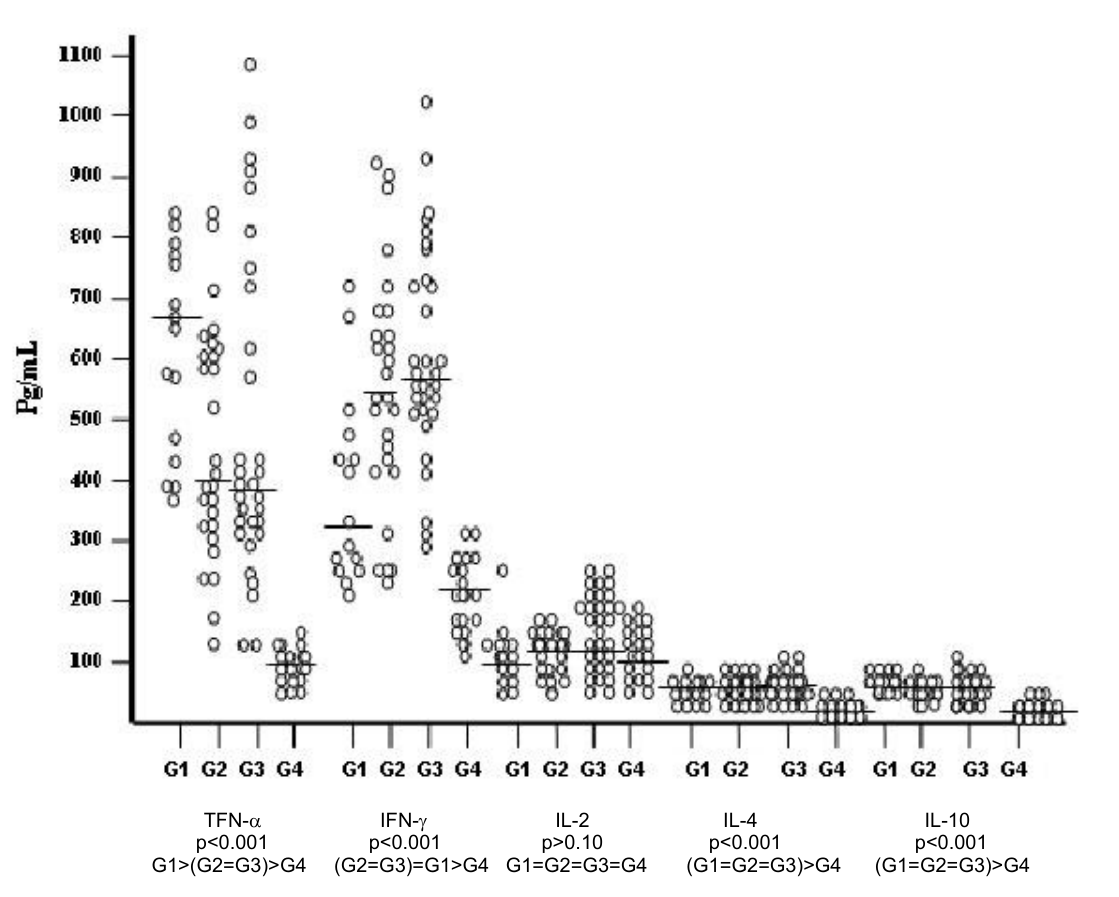
Figure 1. Distribution of serum cytokine values per group (ELISA). = median G1: 15 HIV-1 patients virgin to treatment; G2: 27 HIV-1 patients under HAART with detectable VL; G3: 31 HIV-1 patients under HAART with undetectable VL; G4: 20 normal blood donor